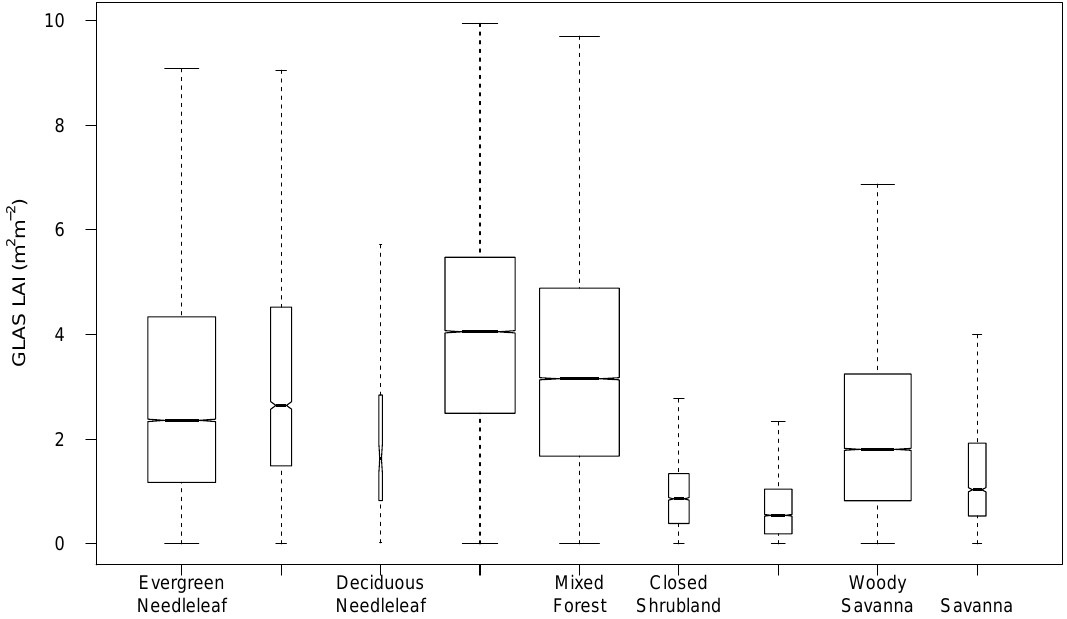
Figure 7. Distribution of total GLAS LAI across different land cover types. The width of the boxes is proportional to the number of observations for each type ( N : Evergreen Needleleaf: 45207; Evergreen Broadleaf: 438; Deciduous Needleleaf: 123; Deciduous Broadleaf: 48283; Mixed Forest: 62053; Closed Shrubland: 4087; Open Shrubland: 7364; Woody Savanna: 43536; Savanna: 3051). Notches show the approximate 95% confidence interval of the median.